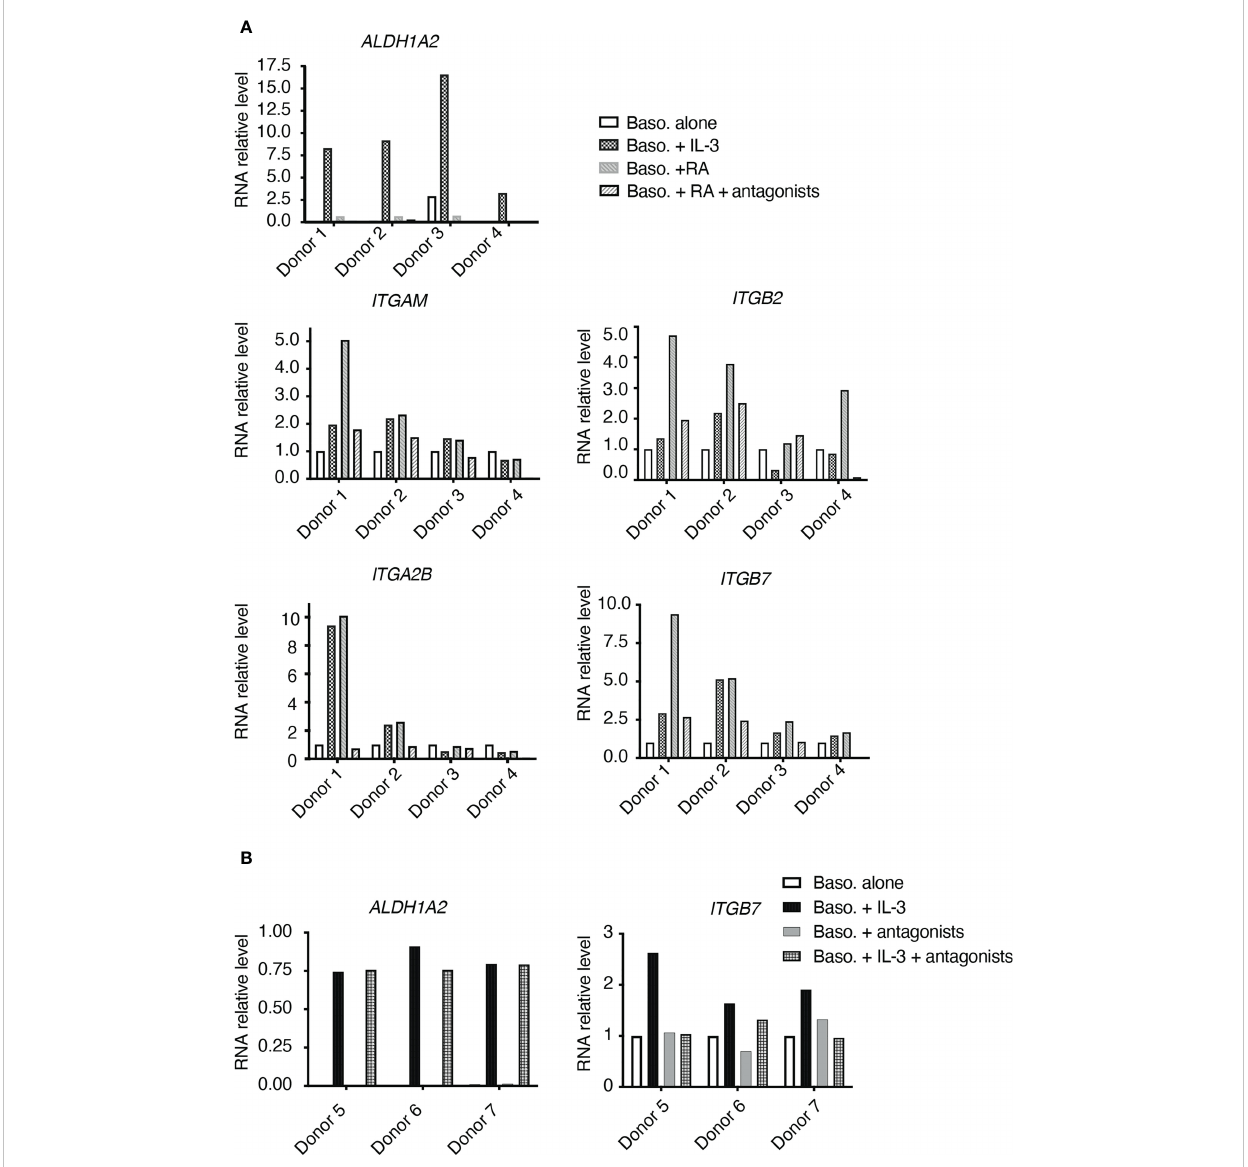
FIGURE 7 RT-qPCR analyses of in vitro cultured human basophils. (A) Basophils isolated from 4 donors (Donor 1, 2, 3, 4) were cultured alone, or in the presence of IL-3, all-trans retinoic acid (RA), or RA+RAR antagonists. (B) Basophils isolated from 3 donors (Donor 5, 6, 7) were cultured alone, or in the presence of IL-3, RAR antagonist, or IL-3+RAR